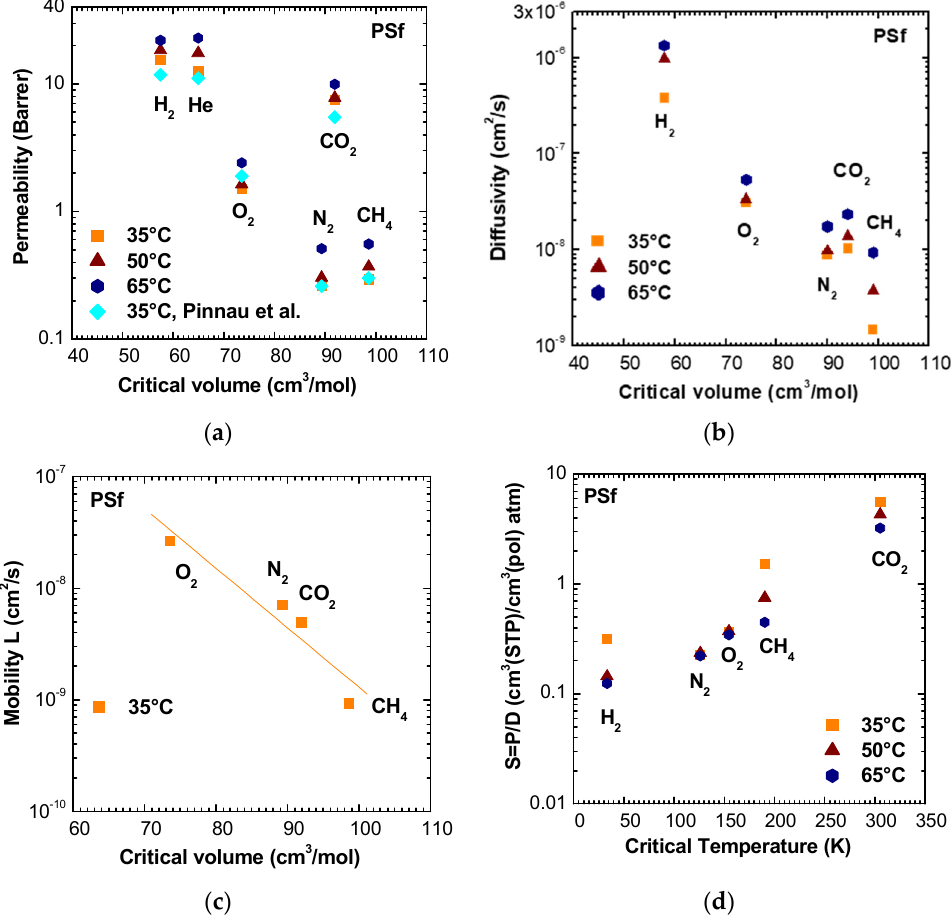
Figure 4. ( a ) Permeability and ( b ) diffusivity of various gases in PSf at 35, 50, and 65 °C as a function of gas critical volume; Permeability data from [50]. ( c ) Mobility of O 2 , CO 2 , N 2 , and CH 4 at 35 °C, calculated as reported in Section S1.1. ( d ) Solubility coefficient of various gases in PSf at 35, 50, and 65 °C as a function of critical temperature.